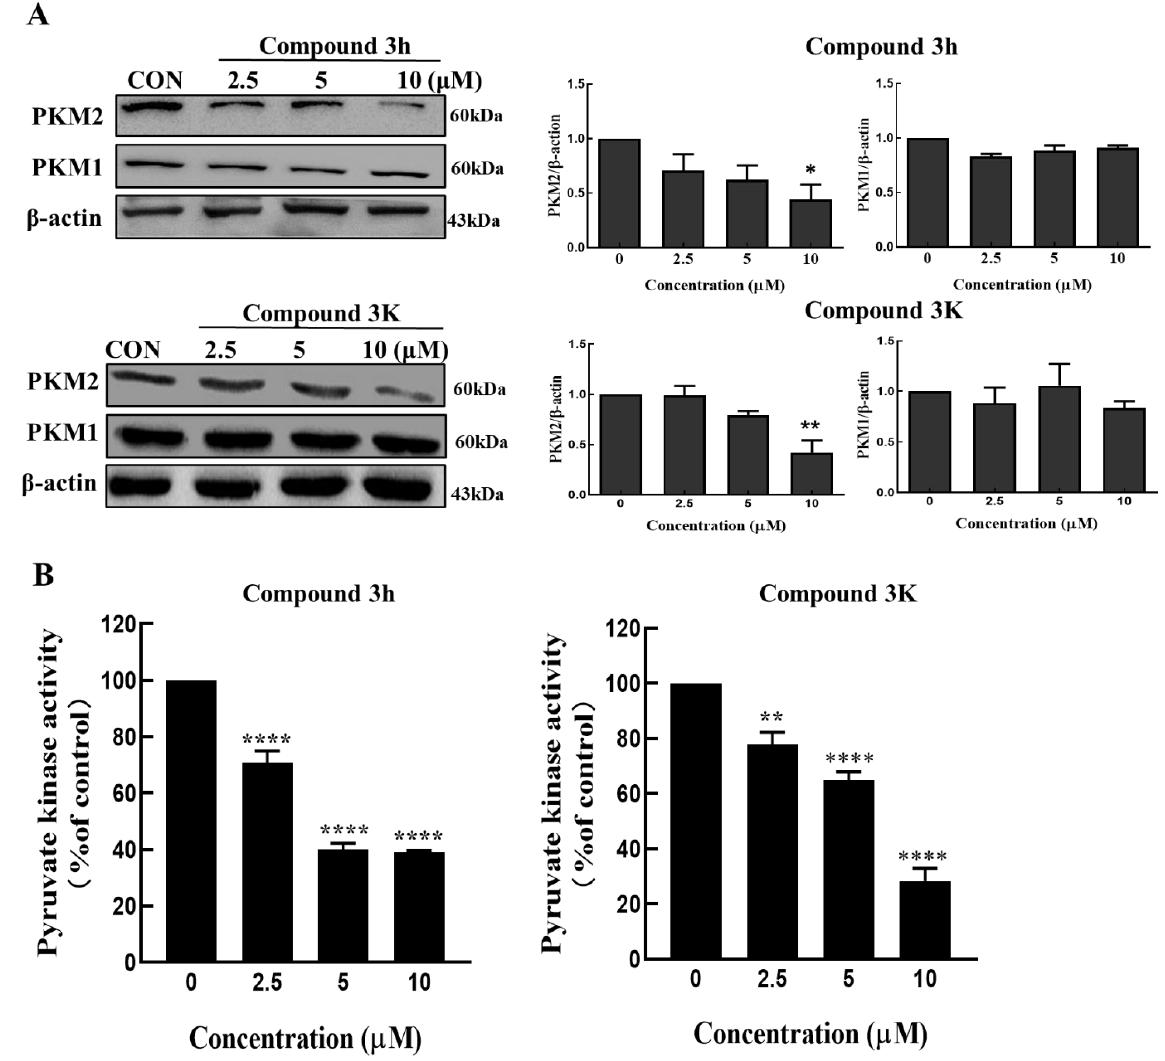
Figure 4. Compound 3K and 3h selectively inhibit PKM2 rather than PKM1. ( A ) Compounds 3K and 3h have a specific selectivity in reducing PKM2 expression in LNCaP cells. ( B ) The activity of pyruvate kinase in LNCaP cells was inhibited by compound 3h and compound 3K depending on concentration. The values represent the mean ± SD. * p < 0.05, ** p < 0.01, and **** p < 0.0001. The uncropped blots are shown Supplementary